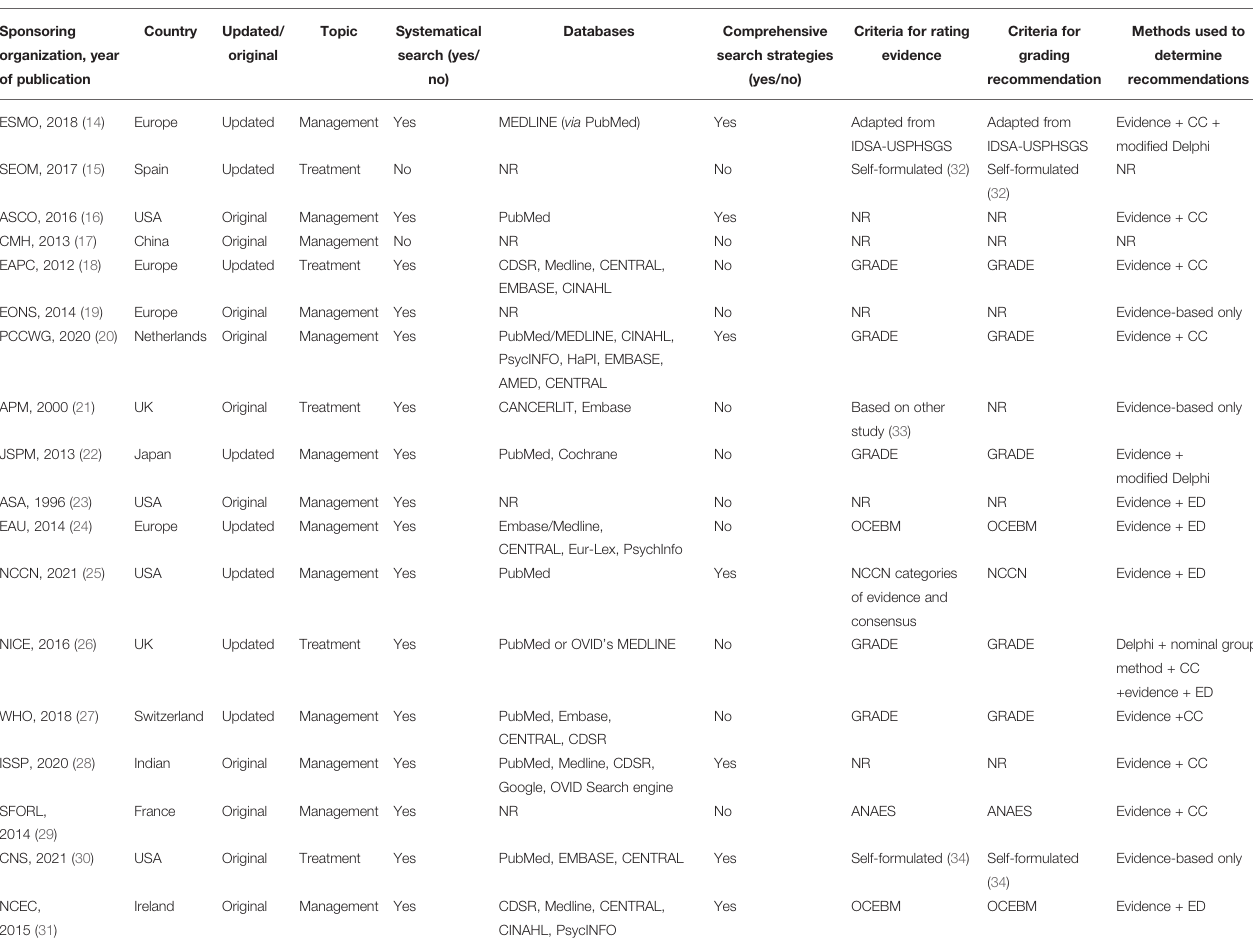
TABLE 1 | Characteristics of the cancer pain